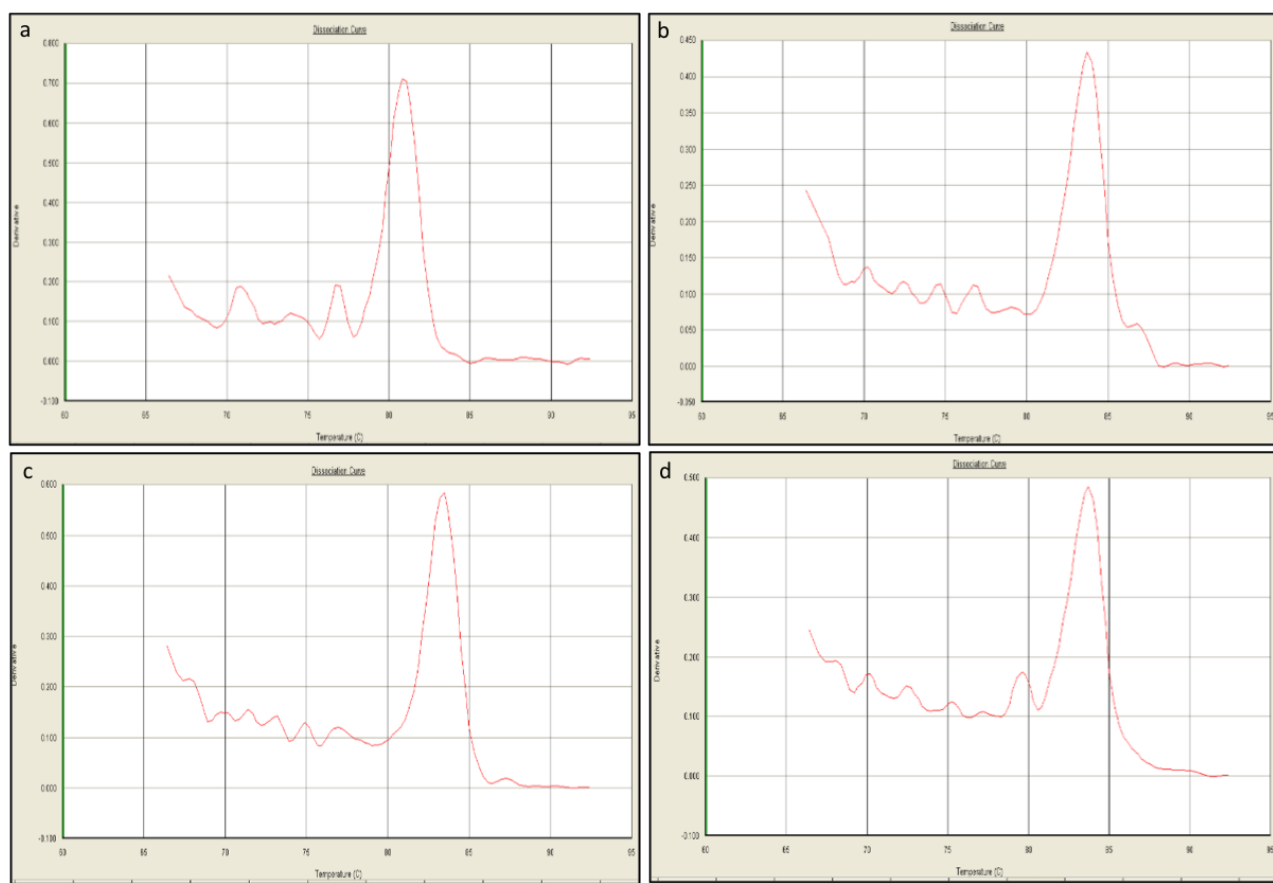
FIGURE 5 - Dissociation curves of qPCR products. The quality of PCR products a: b -Actin, b: KI67, c: DCX and d: NeuN was assessed through dissociation curves and 2% agarose gel electrophoresis. All the values were normalized for b -actin and analyzed relatively using the 2 - ∆∆ CT